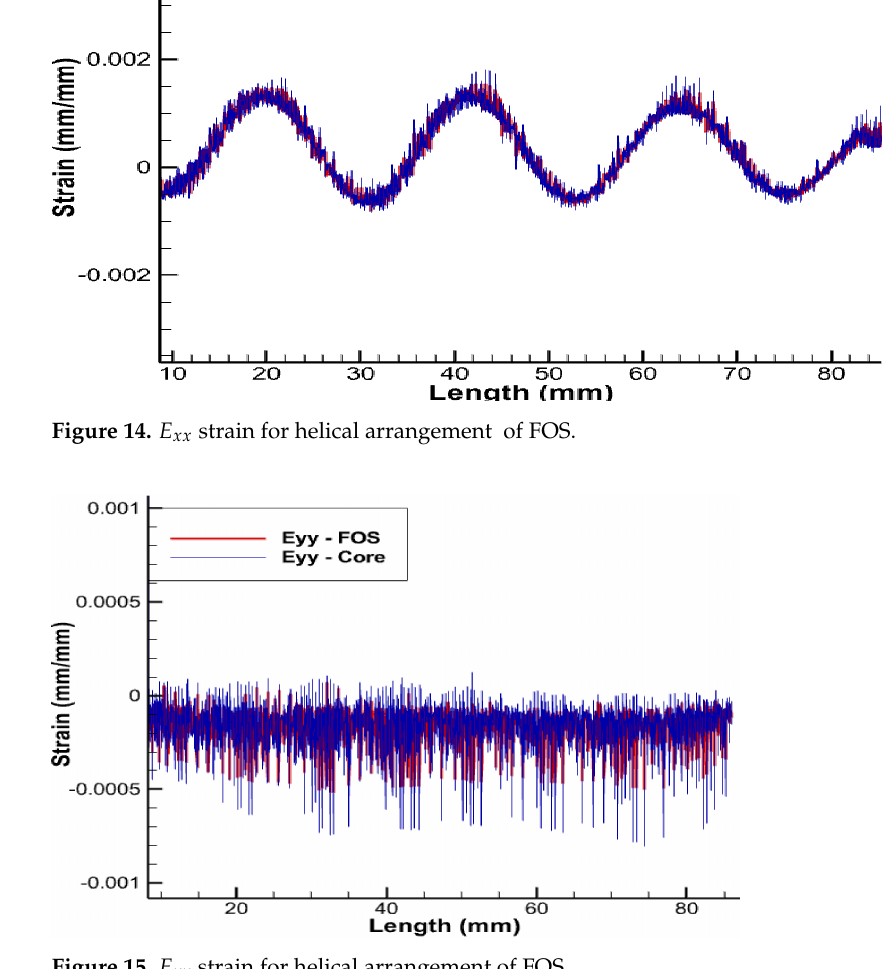
Figure 15. E yy strain for helical arrangement of